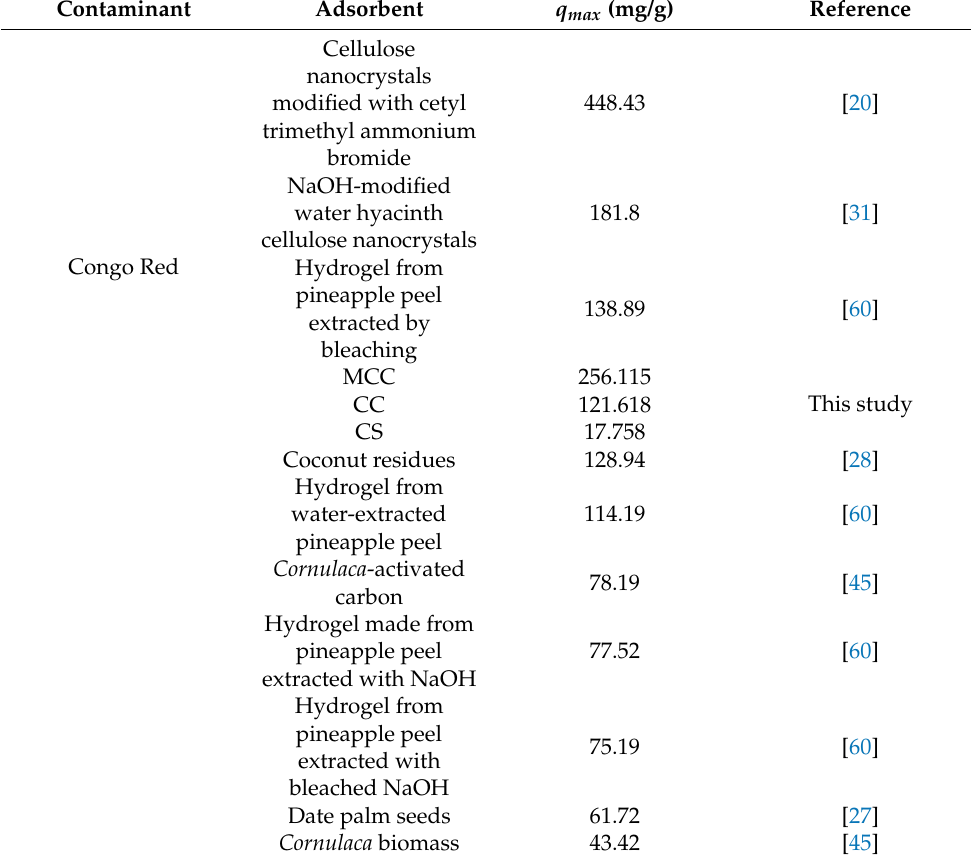
Table 6. q max of CR according to the Langmuir model using various